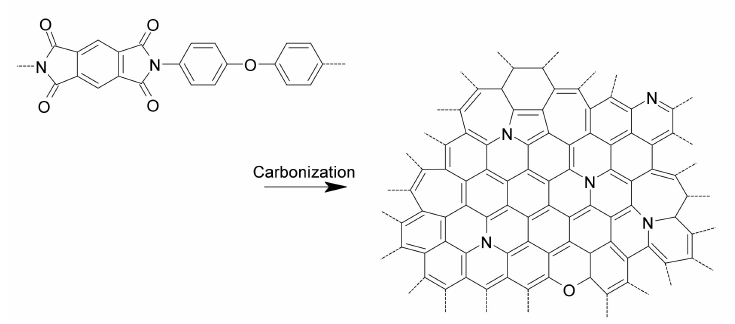
Figure 4. Chemical structure of sp 2 carbon produced after heat treatment of PI.